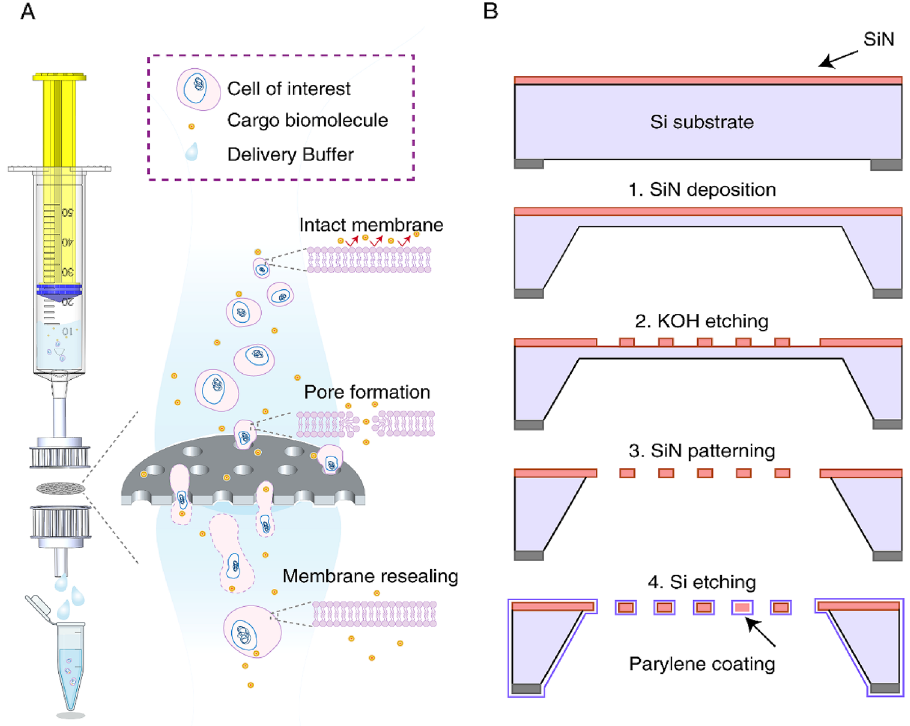
Figure 1. Schematic representation of the MFP delivery system. ( A ) In this platform, as the cells are forced through the microporous filters, they experience mechanical membrane deformations resulting in the generation of multiple discontinuities in the plasma membrane. These transient pores allow passive diffusion of exogenous nanomaterials across the plasma membrane. ( B ) Fabrication process of the SiN microsieves. First, SiN is coated on both sides of silicon (Si) wafers, followed by etching away the bulk Si using the KOH solution. Upon achieving the desired thickness, the surface of the wafers is patterned and then conformally coated with parylene to enhance the strength of the microsieves and reduce the cells attachment and prevent clogging issues. Figure ( A ) was generated using Biorender software (https:// biore nder.